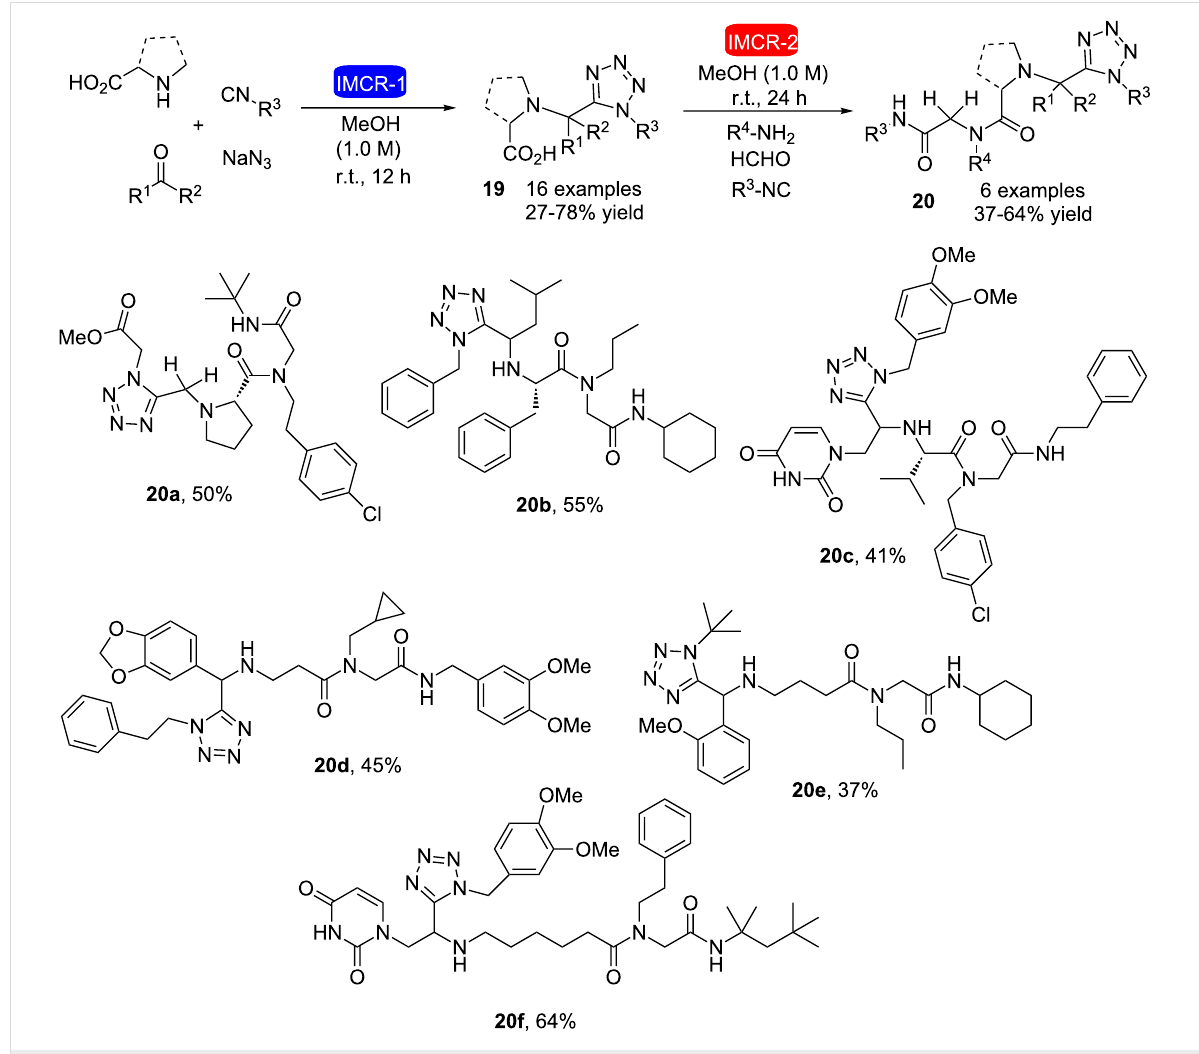
Scheme 6: Synthesis of tetrazole peptidomimetics by direct use of amino acids in two consecutive Ugi reactions [24].